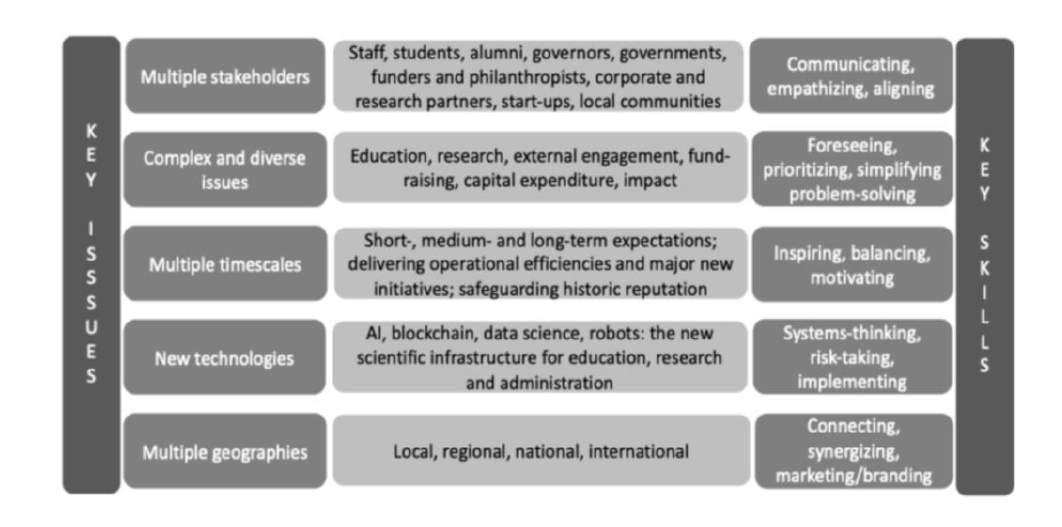
Figure 1: The key challenges and skill requirements of university strategic leaders; Source: Dogson and Gan (2019) The following section focuses on the methodology used in this literature